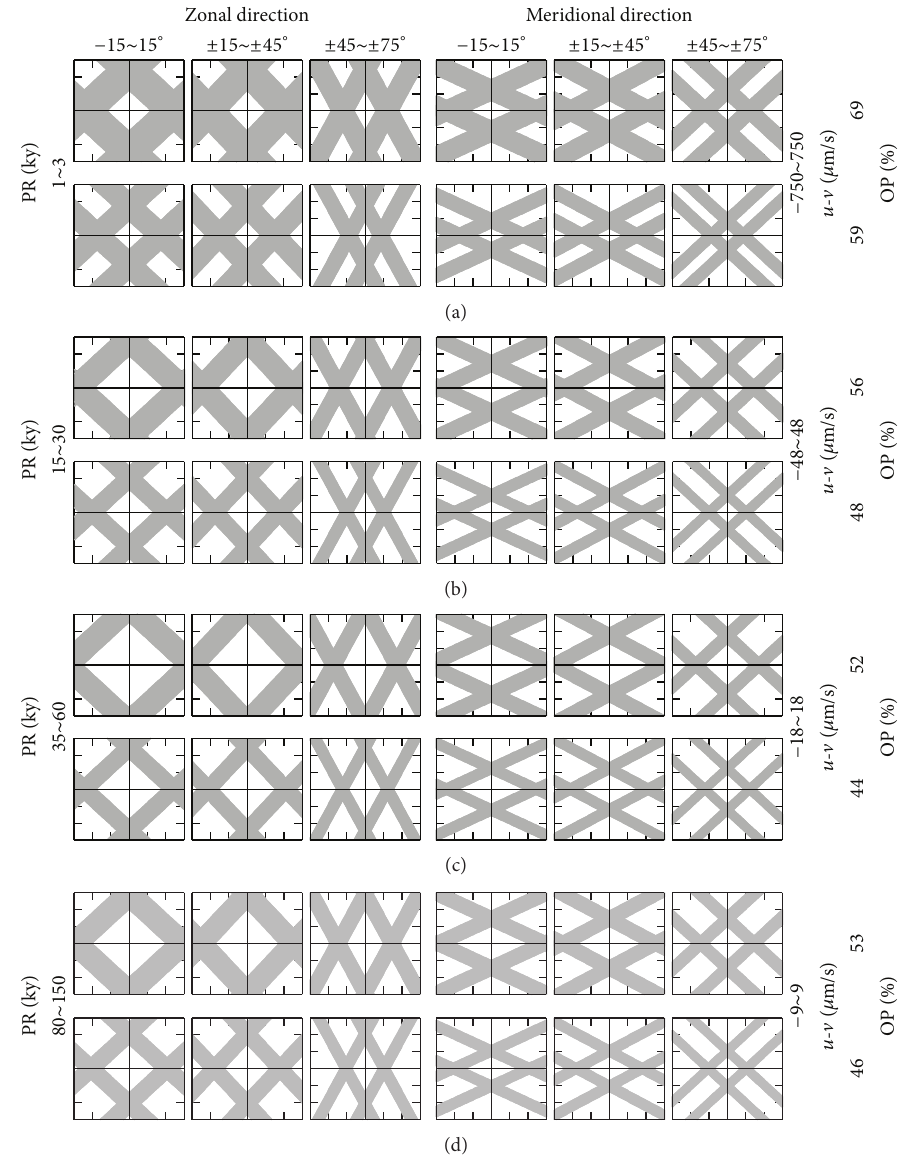
Figure 2: Period ranges (PR, 𝑦 -labels) and their occurring-probability (OP, %). 𝑢/ V , set as the abscissa/ordinate, is the zonal/meridional speed component for magma within the lower mantle/outer core ( 𝜇 m/s, above/below the frame in Rows a, b, c, and d). Columns 1–3/4–6 provide the periodicity of zonal/meridional motion at the labeled latitudes (north is positive). OP is the ratio of the shaded 𝑢 - V area for PR to the total 𝑢 - V area labeled on the “ 𝑢 - V ” column, computed using (6). The OP averaged for Columns 1–6 is labeled on the “OP”